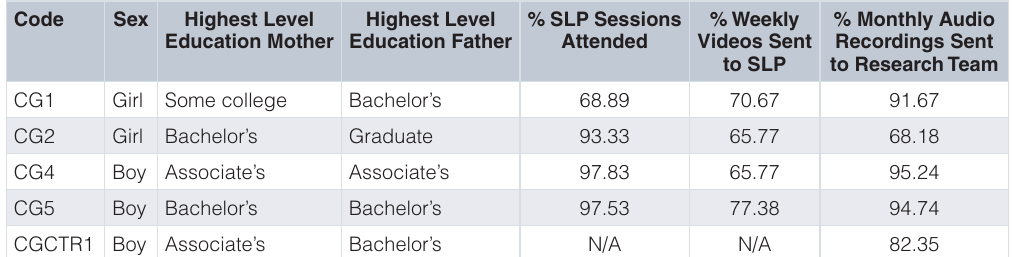
Table 1. Demographic information and fidelity of parent follow-through regarding weekly SLP sessions, weekly home videos, and monthly audio recordings.